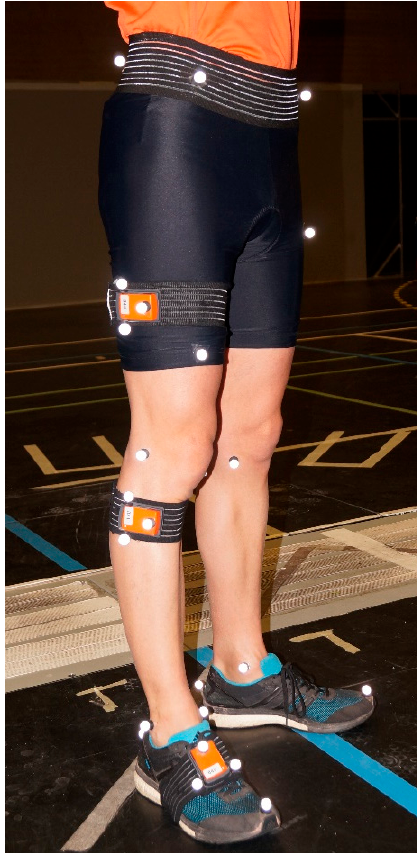
Figure 1. Subject equipped with an inertial measurement unit (IMU) and reflective markers.